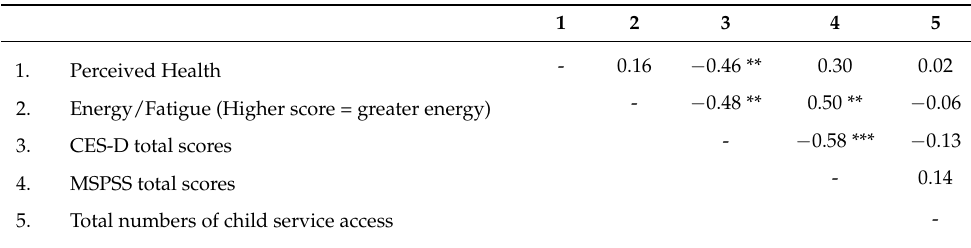
Table 4. Bivariate correlations between outcome and predictor variables.